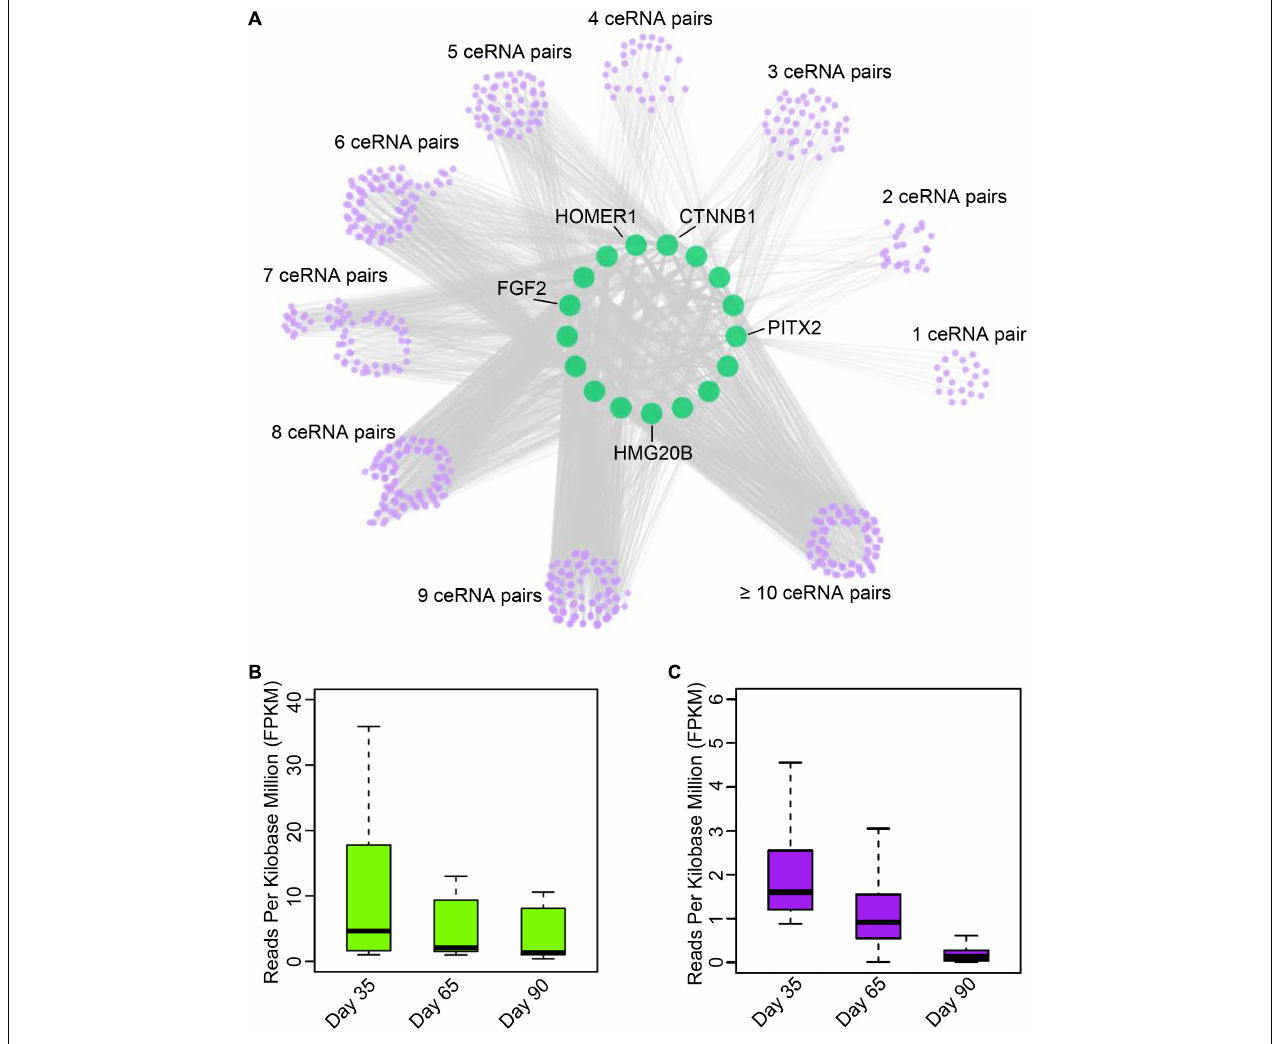
FIGURE 4 | Exploration of circular RNA mediated ceRNA regulatory network. (A) Illustration of the ceRNA interaction network. The purple node represents circRNAs; green node represents key genes related to myogenesis. (B) The boxplot shows the expression dynamics of key myogenesis genes on 33, 65, and 90 days of gestation. (C) The boxplot shows the expression of circRNAs involved in myogenesis on 33, 65, and 90 days of